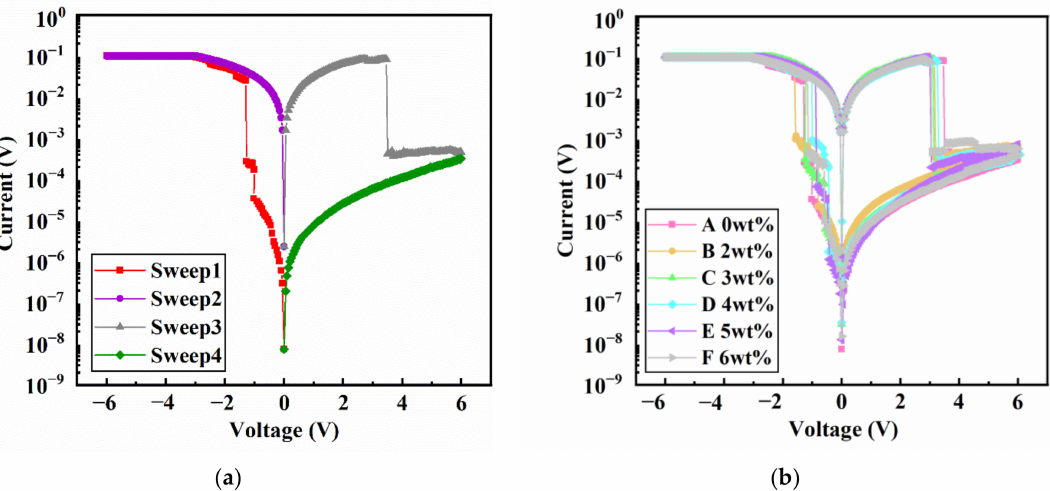
Figure 5. ( a ) I-V curve of ITO/PIB/Al. ( b ) I-V curve of ITO/PIB: SnO 2 NPs/Al at different SnO 2 NPs composite concentrations.